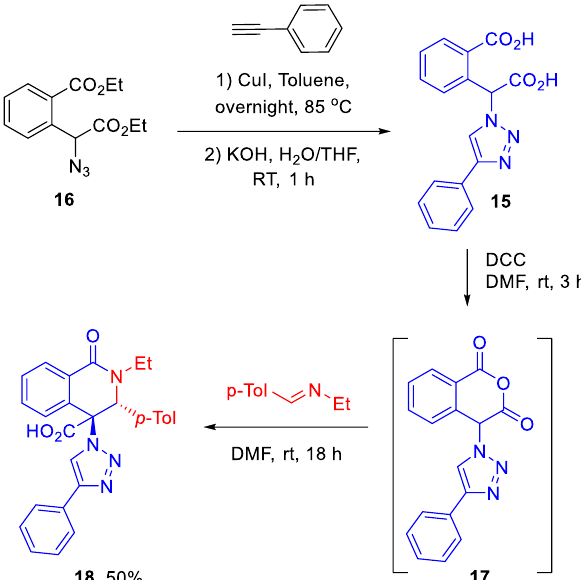
Figure 4. Crystallographic structure of compound 9a (ORTEP plot, 50% probability